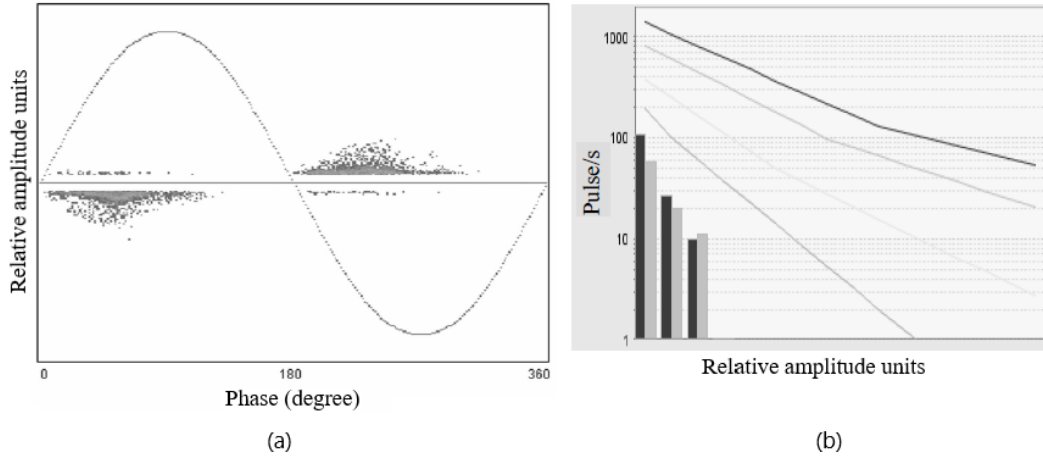
Figure 7. ( a ) PRPD pattern, ( b ) 2D equivalent